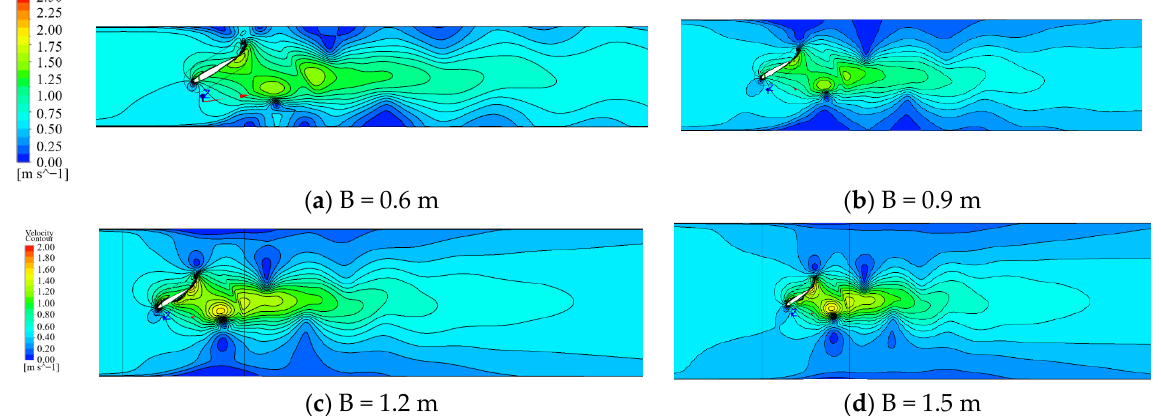
Figure 10. Velocity cloud chart of flapping hydrofoil under different passage widths.